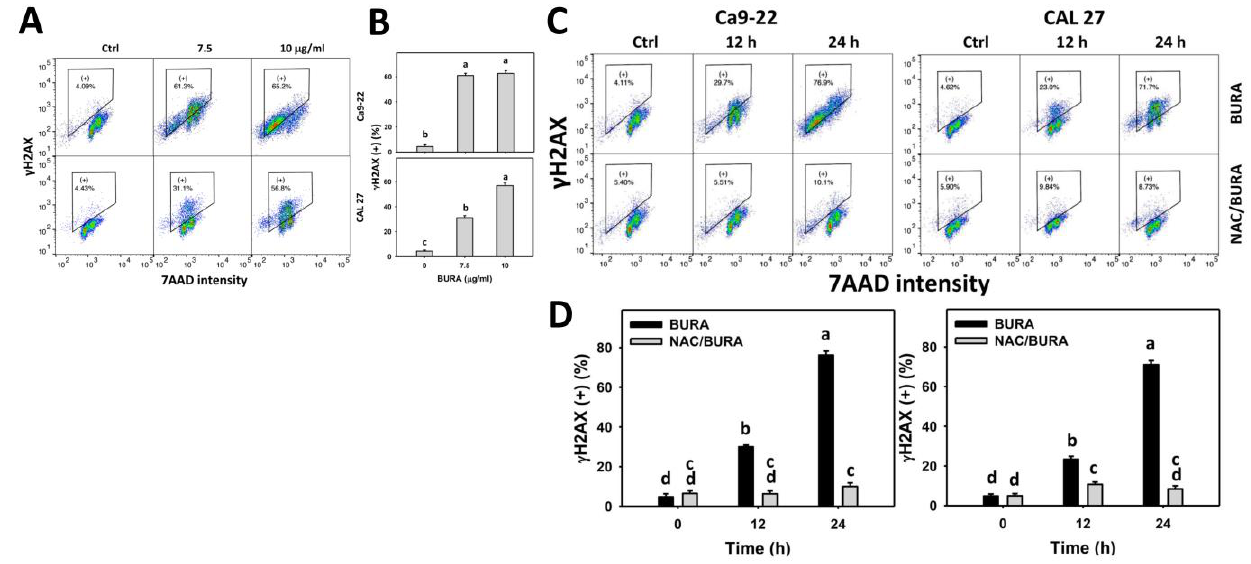
Figure 8. BURA causes γH2AX DNA damage in oral cancer cells. ( A , B ) γH2AX pattern and quantification. Oral cancer cells (Ca9-22 and CAL 27) were treated with BURA (control (0.1% DMSO), 7.5 μg /mL (25.3 μM), and 10 μg /mL (33.8 μM), 24 h). (+) located within the patterns represented by γH2AX (+). ( C , D ) NAC effect on γH2AX patterns and quantification. After NAC treatment (10 mM, 1 h), cells were treated with BURA (10 μg /mL) for 0 (control), 12 and 24 h. Data, mean ± SD ( n = 3). Data top-labeled with non-overlapping lower-case letters differ significantly according to multi-comparisons ( p < 0.05).